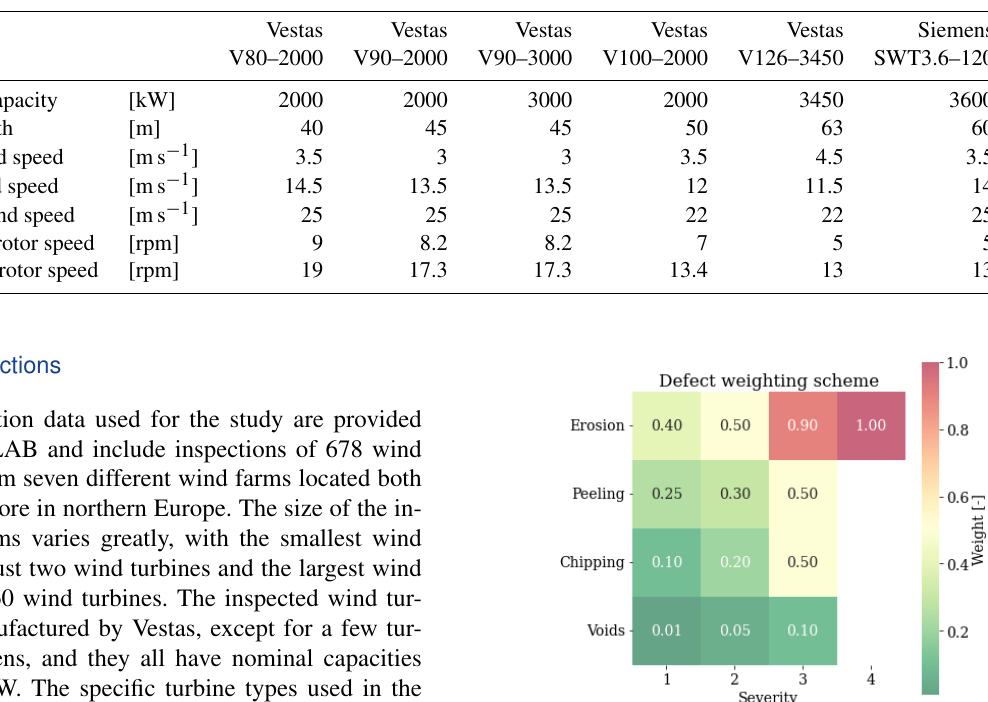
Table 1. Summary of turbine types and the assumed basic operational characteristics.